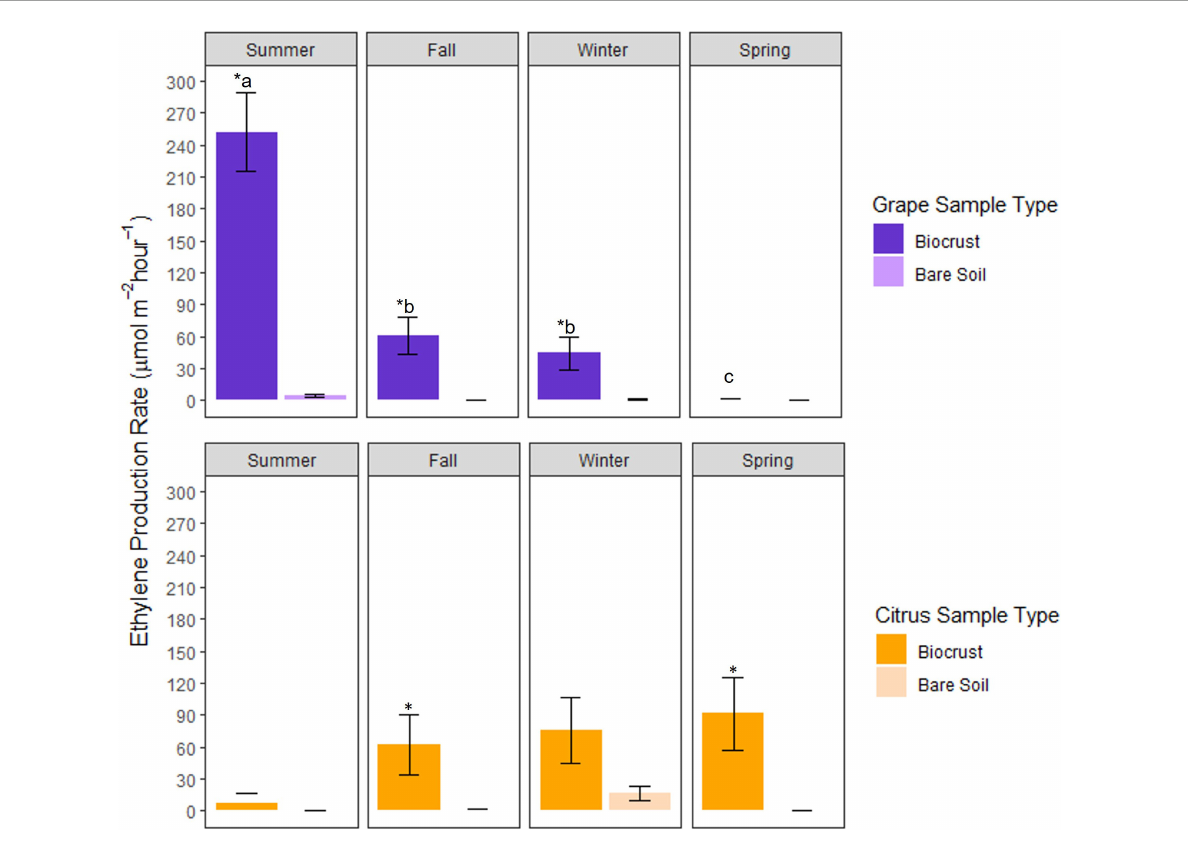
FIGURE2 Seasonal rates of acetylene reduction (ethylene production) for biocrusts at the Grape and Citrus sites. The asterisk above the biocrust bar within a season indicates a significant difference between biocrusts and bare soils for a given sampling date, while letters indicate a significant difference between biocrusts of different seasons ( ∗ P < 0.05; n = 6, mean ± SE). One month prior to sampling in the summer at Citrus, controlled release fertilizer was applied at a rate of 29 kg N ha − 1